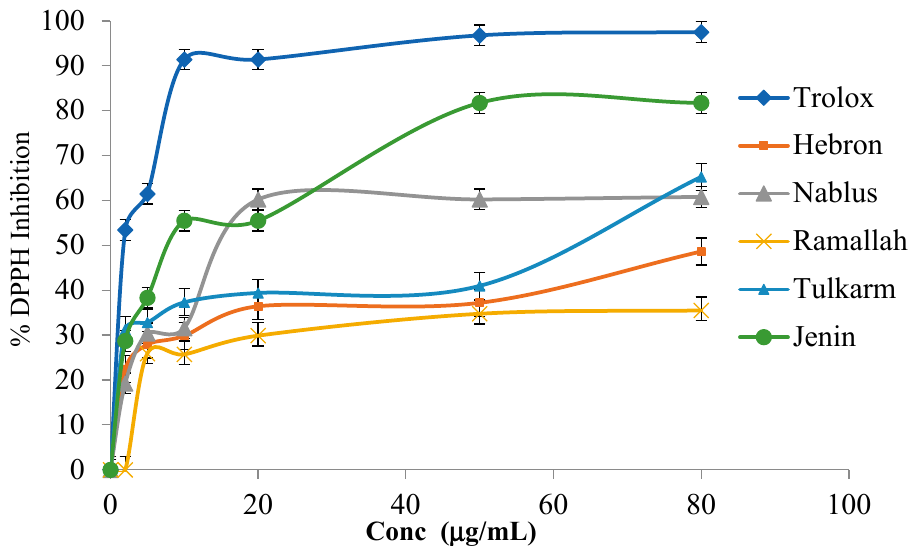
Figure 3. DPPH inhibitory potentials by Rosmarinus officinalis essential oils from five Palestinian regions and Trolox.